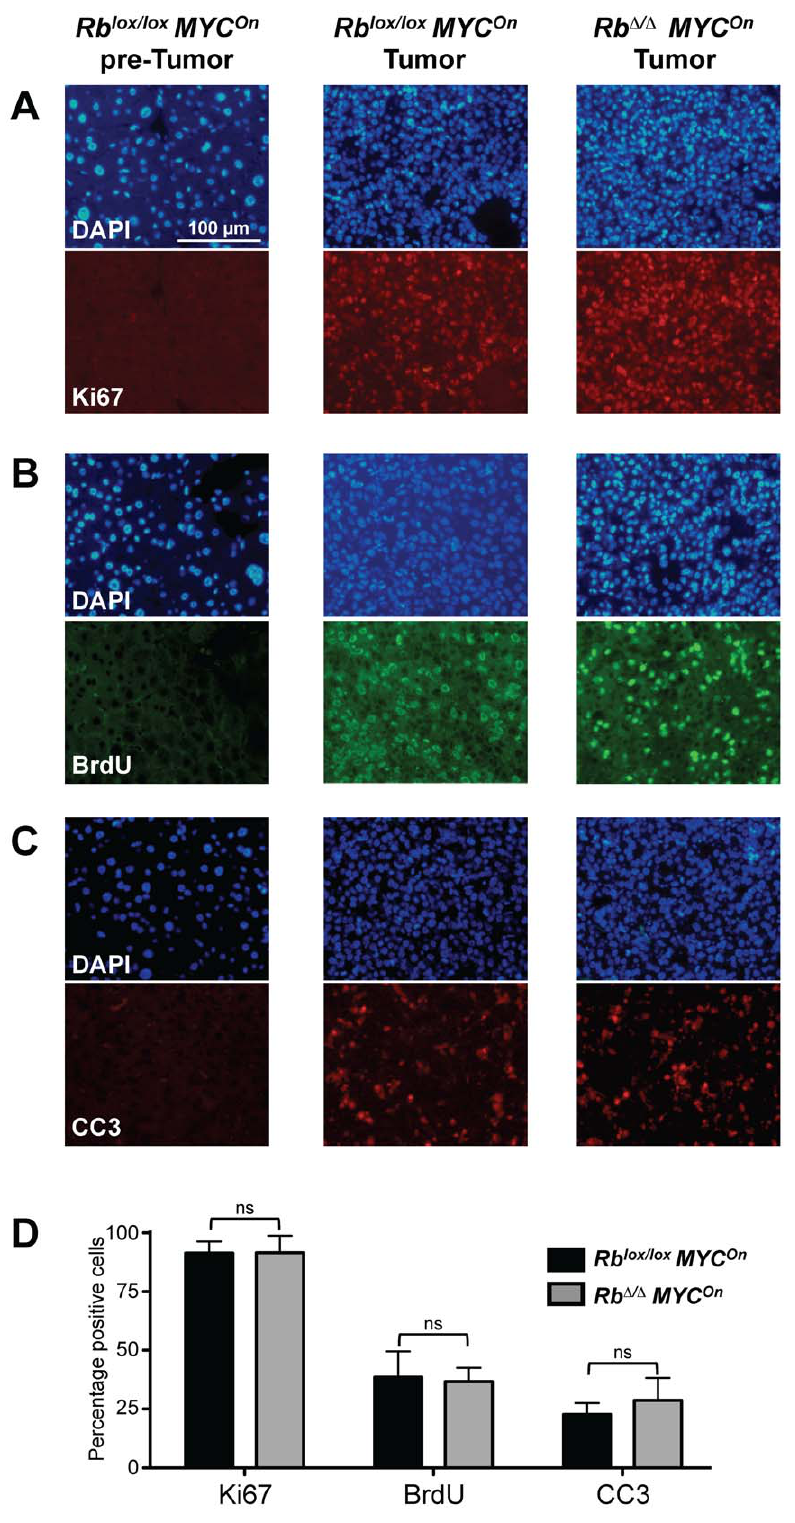
Figure 3. Rb inactivation does not affect the degree of proliferation or cell death of MYC-induced HCC. A–C. Immunofluorescence staining for Ki67 ( A ), BrdU ( B ), and cleaved caspase 3 (CC3) ( C ) on MYC mutant non-tumor liver tissue and tumor tissue from MYC and MYC/Rb mutant mice. DAPI nuclear staining is used to indicate the density of cells on the sections. The pictures shown are representative of each group. D. Quantification of staining shown in A. The number of positively stained cells for each antibody over the number of DAPI stained cells expressed as a percent was determined using the BioQuant software. For each antibody and genotype combination the average of n=2 mice was calculated where each n is the average percent of positive cells from three fields containing at least 250 cells each.